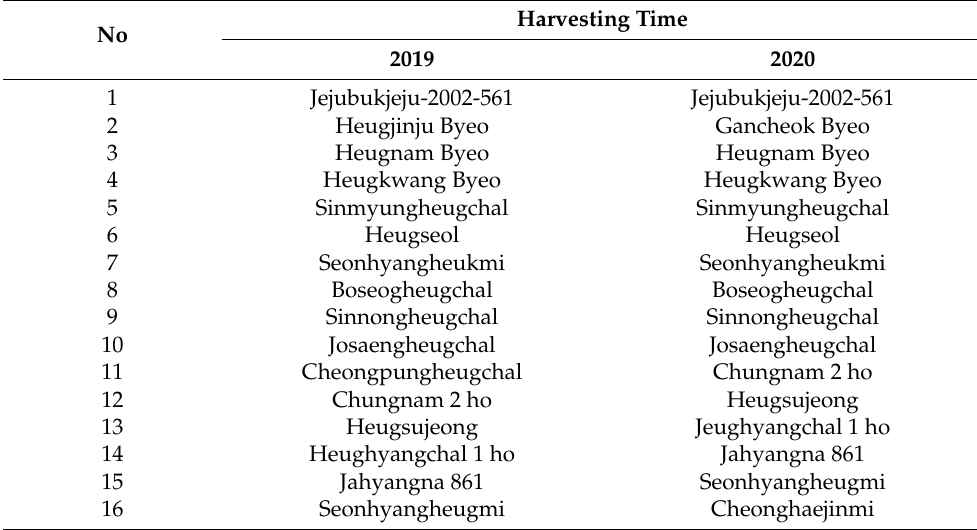
Table 1. List of examined black rice varieties of two years harvesting time.